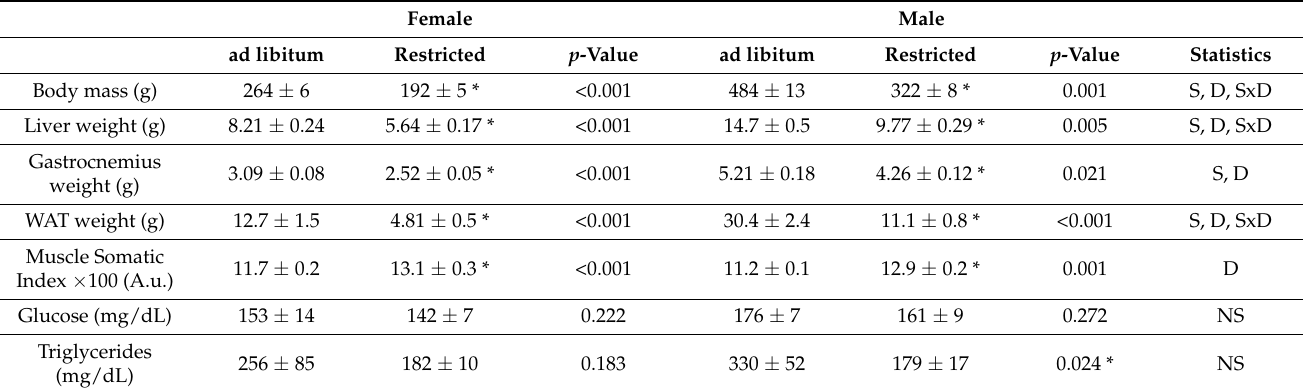
Table 1. Body and tissue weights, glucose and triglycerides levels in control and restricted rats. Two-way ANOVA was performed to assess for significance. Abbreviations: S, sex differences; D, diet differences; SxD, interactive effect between sex and diet; NS, non-significant. WAT weight: represents sum of inguinal, lumbar, mesenteric, epididymal/ovarian adipose tissues weights. * Statistical differences between calorie restricted and control groups.